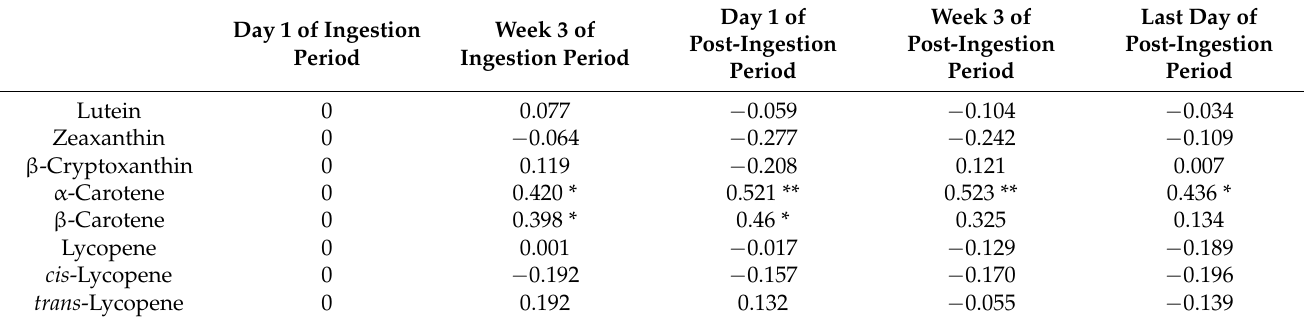
Table 4. Correlation coefficients between cutaneous carotenoid level and blood carotenoid concentration changes from day 1 of the ingestion period.